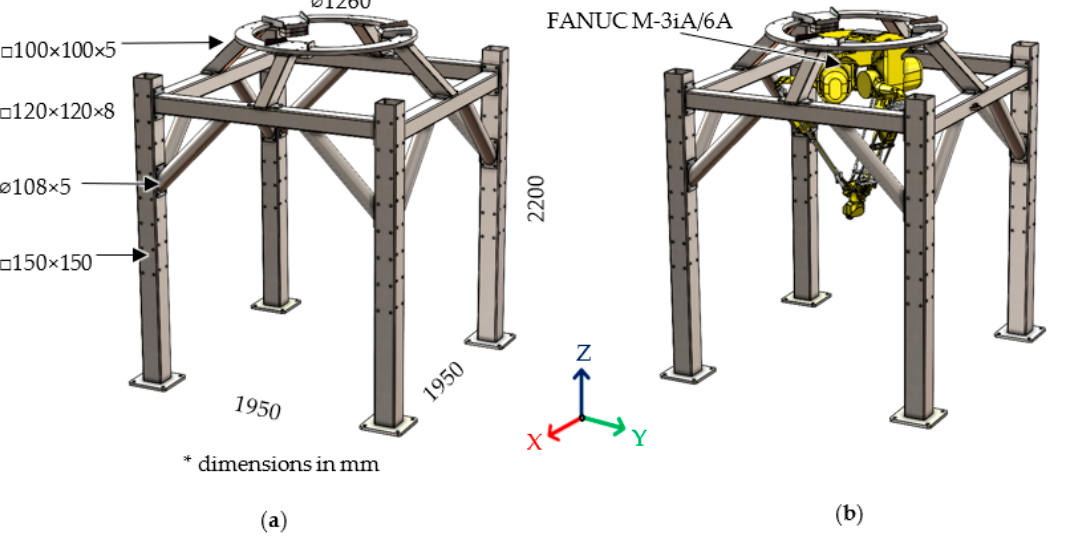
Figure 1. Analyzed frame ( a ) dimensions and ( b ) robot assembly.